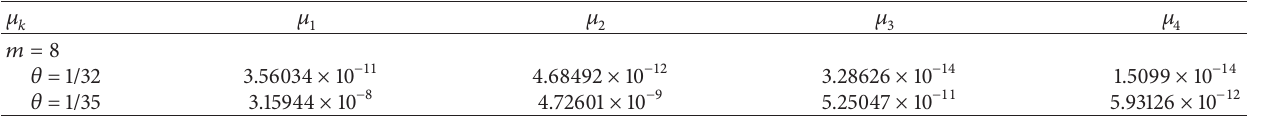
Table 5: Absolute error |𝜇 𝑘 − 𝜇 𝑘,𝑁 | .